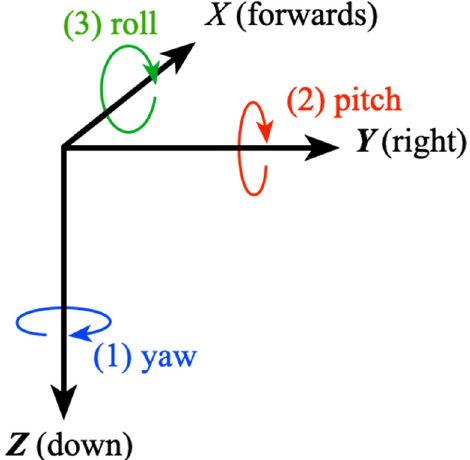
Figure 1. Tait–Bryan intrinsic rotations in the object’s FOR.